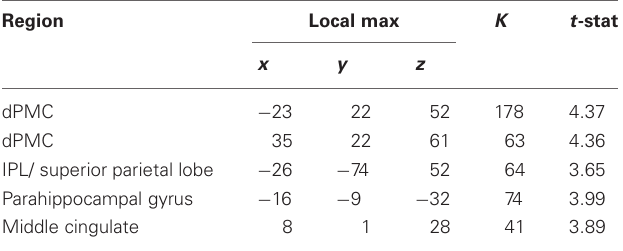
Table 3G | Human-coded enthusiasm, controlling SA rated positive.